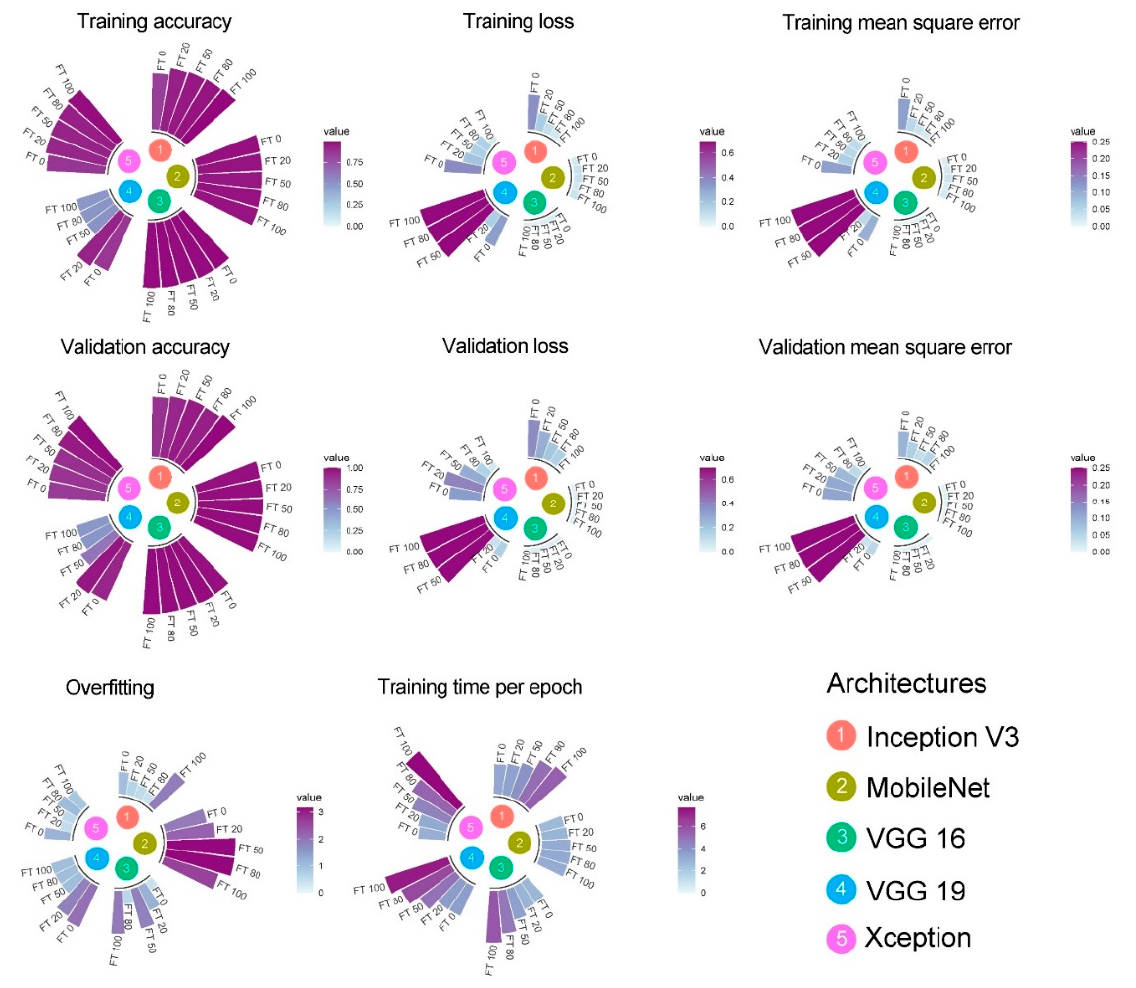
Figure 4. Variables measured during the fine-tuning of pretrained convolutional neural networks. The architectures tested were MobileNet, InceptionV3, VGG16, VGG19, and Xception, with different percentages of weights from the ImageNet dataset. We fine-tuned 0% (FT 0) with a convolutional base using all weights from ImageNet, 20% (FT 20), 50% (FT 50), 80% (FT 80), and 100% (FT 100) training of the complete network with the weights initialized randomly. The training time per epoch is measured in